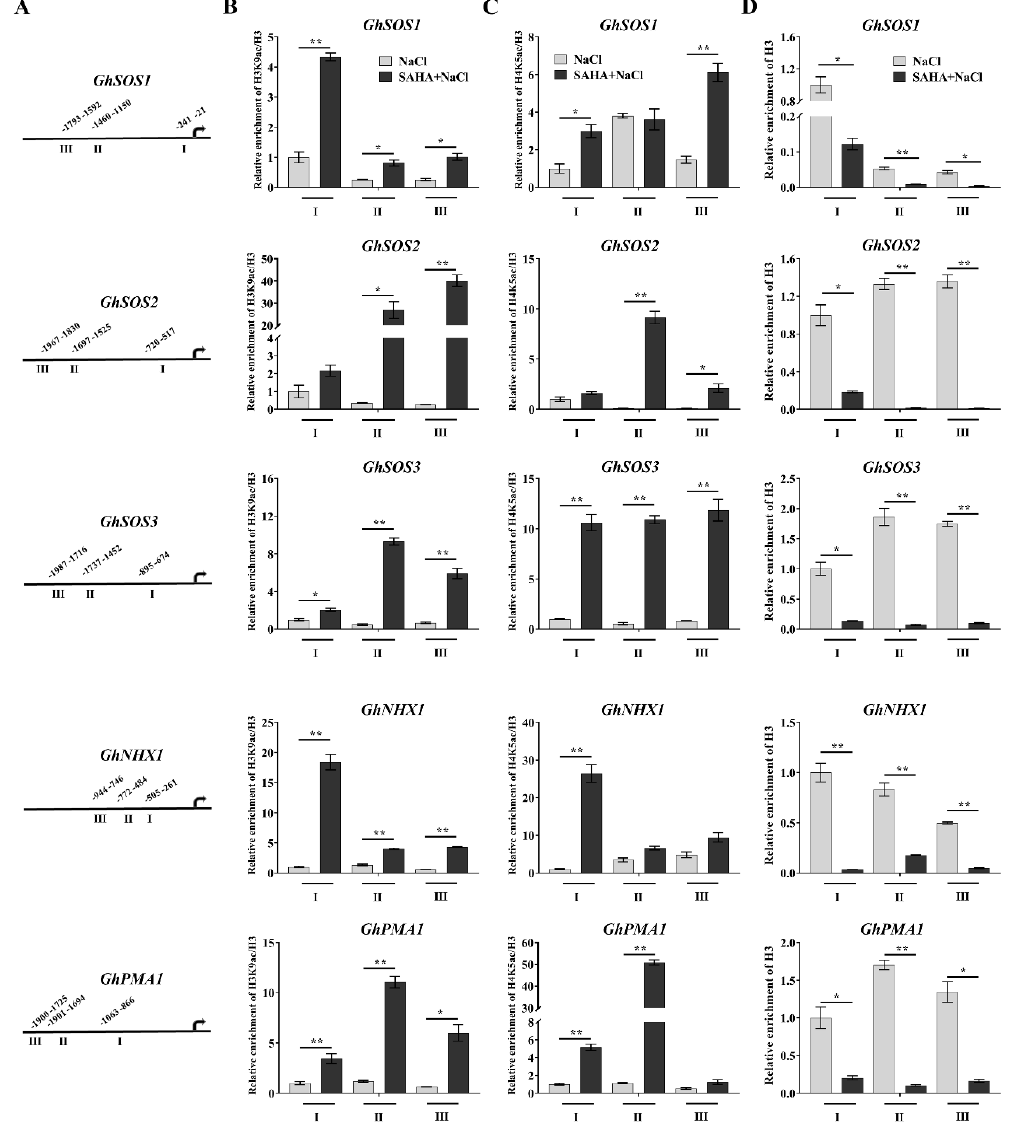
Figure 5. Alterations of H3K9ac, H4K5ac, and H3 on the promoter regions of the ion homeostasis-related genes by SAHA pretreatment in leaves under 250 mM NaCl stress for 0.5 h. ( A ) Detected regions (I, II, and III) of GhSOS1 , GhSOS2 , GhSOS3 , GhNHX1 , and GhPMA1 for chromatin immunoprecipitation (ChIP)-qPCR assay. ( B – D ) Alterations of the enrichment of H3K9ac ( B ), H4K5ac ( C ), and H3 ( D ) on the promoter regions of GhSOS1 , GhSOS2 , GhSOS3 , GhNHX1 , and GhPMA1 . Values represent the means ± SD of three biological replicates. Student’s t -test, * p < 0.05, ** p < 0.01.